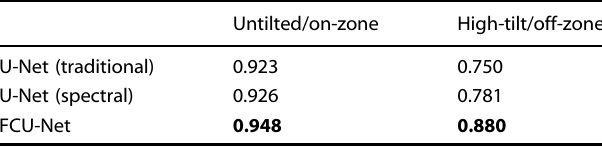
Bold values indicate highest SSIM value for each